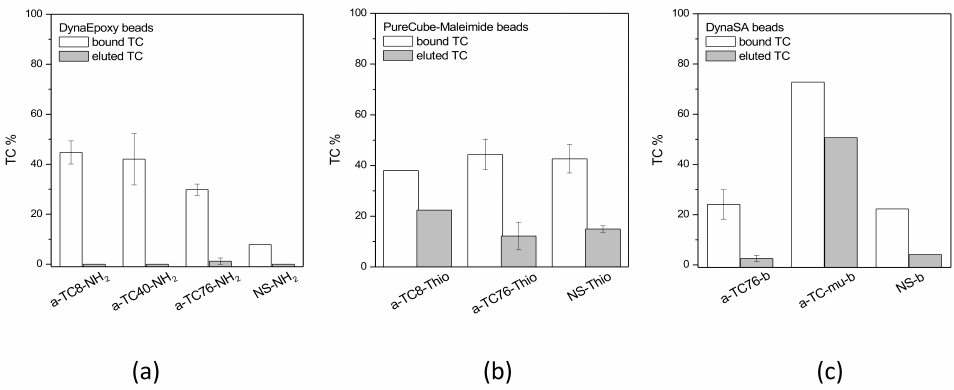
Figure 6. Binding of tetracycline to beads functionalized with aptamers. The percentage of TC is referred to the initial antibiotic added to the beads and set as 100% TC. ( a ) Beads exposing epoxy groups functionalized with amino-terminated aptamers; ( b ) beads exposing maleimide groups functionalized with thiol-terminated aptamers; ( c ) beads exposing streptavidin functionalized with biotin at 5 (cid:48) . The elution step was performed with 2 M NaCl and heating at 80 °C. All reactions were carried out in 1.5 mL vial, fractions of each step were collected and quantified with HPLC. NS: nonsense aptamers. Means and standard errors are